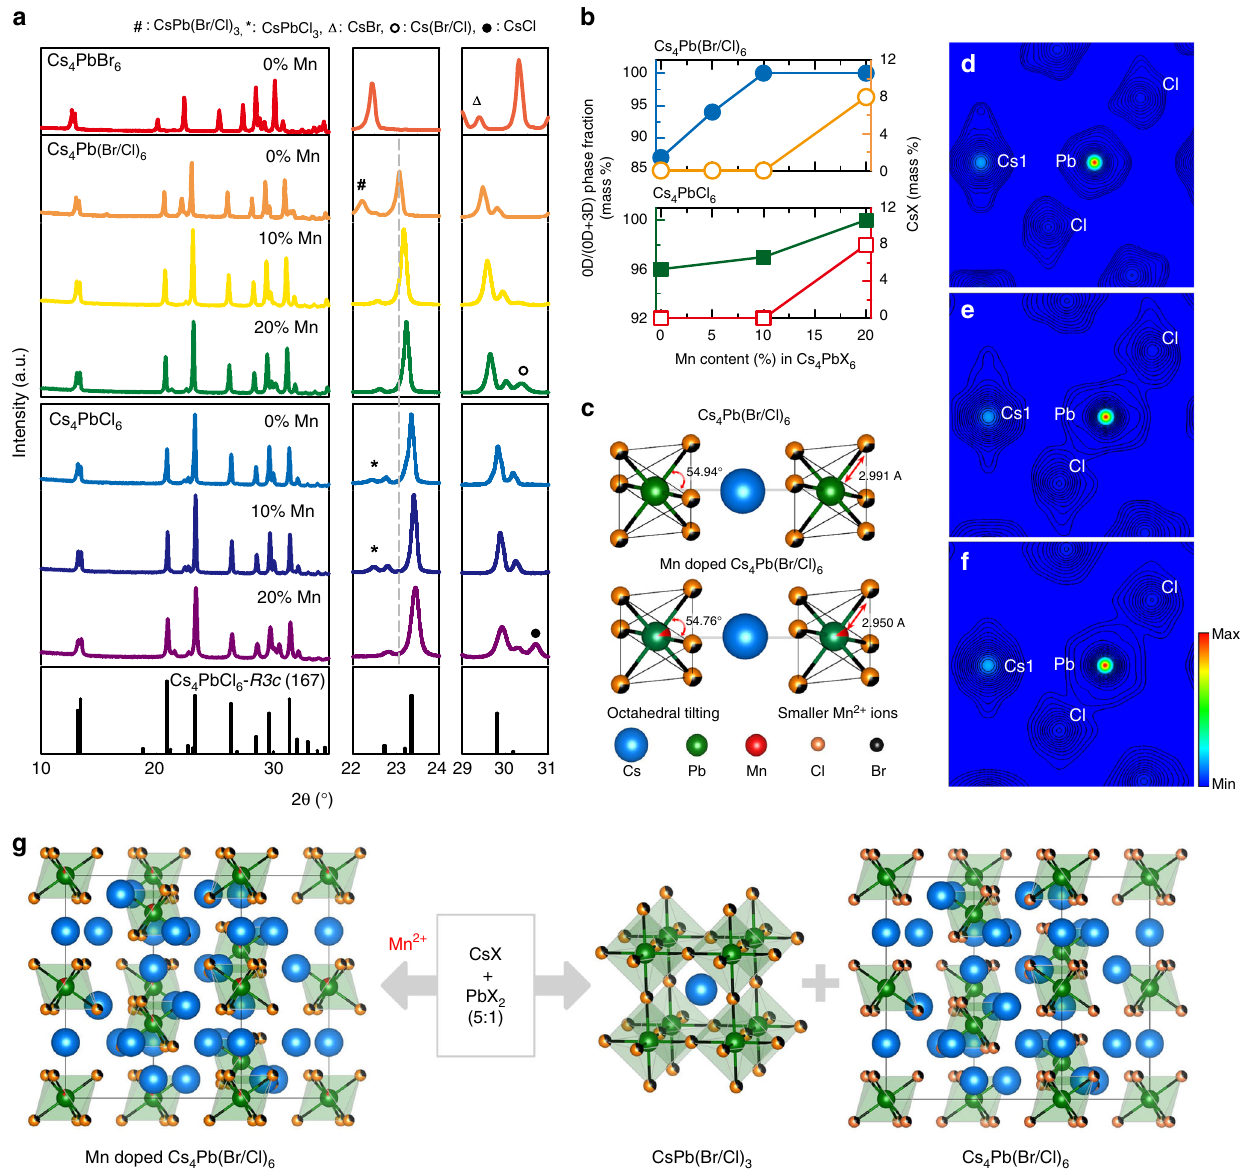
Fig. 1 Local and bulk structures of Mn 2 + -doped Cs 4 PbX 6 . a X-ray diffraction patterns of Mn 2 + -doped Cs 4 PbX 6 series with different doping concentrations showing the rhombohedral structure is preserved after Mn-doping. Selected 2 θ range of (22 to 24° and 29 to 31°) XRD patterns were presented. A monotonic shift of the XRD peak at Bragg ’ s angle at 23.4° towards higher 2 θ is the result of progressive lattice contraction as the Mn 2 + concentration increases, due to the substitutional replacement of Pb 2 + with isovalent but smaller Mn 2 + ions. The additional impurity cubic phases of 3D CsPb(Br/Cl) 3 , 3D CsPbCl 3 , CsBr, Cs(Br/Cl), and CsCl were denoted as hash, asterisk, triangle, open circle, and closed circle, respectively. It is to be noted that the Cs:Pb precursor ratio was fi xed at 5:1 for all the samples of Cs 4 PbX 6 (Br, Cl, and Br/Cl). b Phase fraction of the desired 0D Cs 4 PbX 6 perovskite with respect to 3D CsPbX 3 perovskite phase and segregation of CsX, with varying Mn concentration in the Cs 4 PbX 6 synthesis. c Octahedral tilting/distortion without and with Mn doping (10% Mn) causing the phase stabilization of Cs 4 Pb(Br/Cl) 6 structure. Electron density distribution pro fi le derived from Maximum Entropy method for the d undoped Cs 4 PbCl 6 , e Cs 4 PbCl 6 :10% Mn, and f Cs 4 PbCl 6 :20% Mn, along the (010) plane. g Schematic representation of